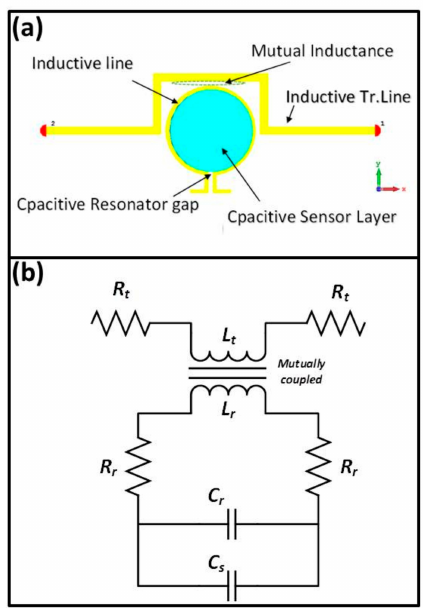
Figure 3. ( a ) Capacitive and inductive part; ( b ) the equivalent circuit diagram of the proposed MTM integrated transmission line-based sensor